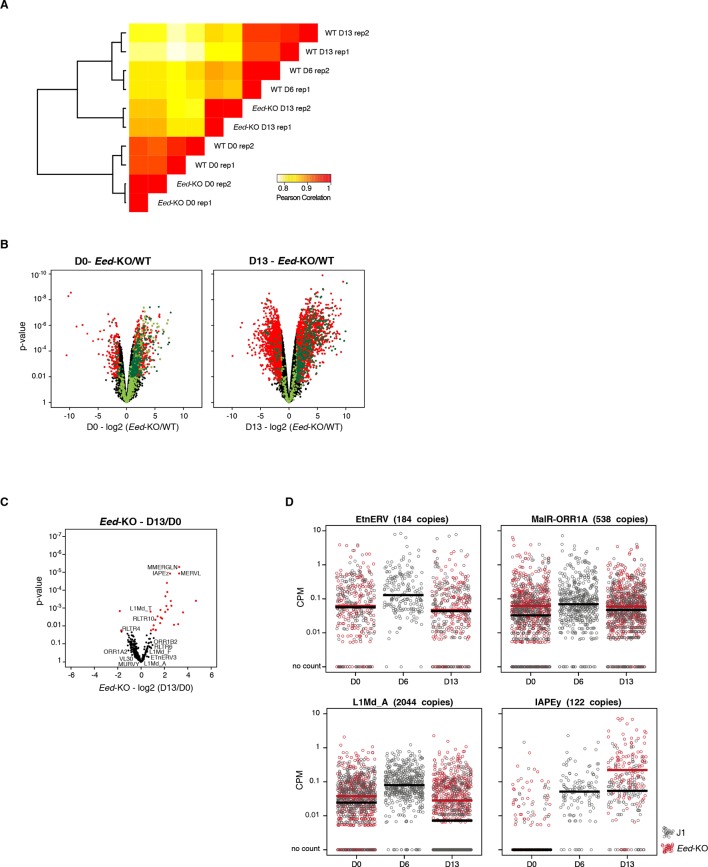
RNA-seq of Eed-KO ES cells(A) Pearson correlation and hierarchical clustering between RNA-seq experiments. (B) Volcano plot representation of up- and down-regulated genes as measured by RNA-seq between WT and Eed-KO at D0 (left) and D13 (right). Light and dark green dots represent genes with a H3K27me3 peak in promoter regions (2222 and 1870 genes at D0 and D13, respectively). Red and dark green dots indicate significantly misregulated genes (fold change >4 and p-value <0.01). (C) Volcano plot representation of up- and down-regulated transposons as measured by RNA-seq between D0 and D13 in Eed-KO. Red dots indicate significantly misregulated repeats between two conditions (fold change >2 and p-value <0.05). RNA-seq mapping allowed multiple hits onto the genome. (D) Expression of individual elements from different transposon families at D0, D6 and D13, in WT and Eed-KO, in Count per Millions (CPM). Each dot represents a single element. RNA-seq mapping allowed only unique hits in the reference genome; only elements with a minimum of 10 reads in at least one of the sample were conserved. The black and red bars represent the median of the distribution, for WT and Eed-KO, respectively. Analyzed numbers of distinct transposon copies per family appear into brackets.